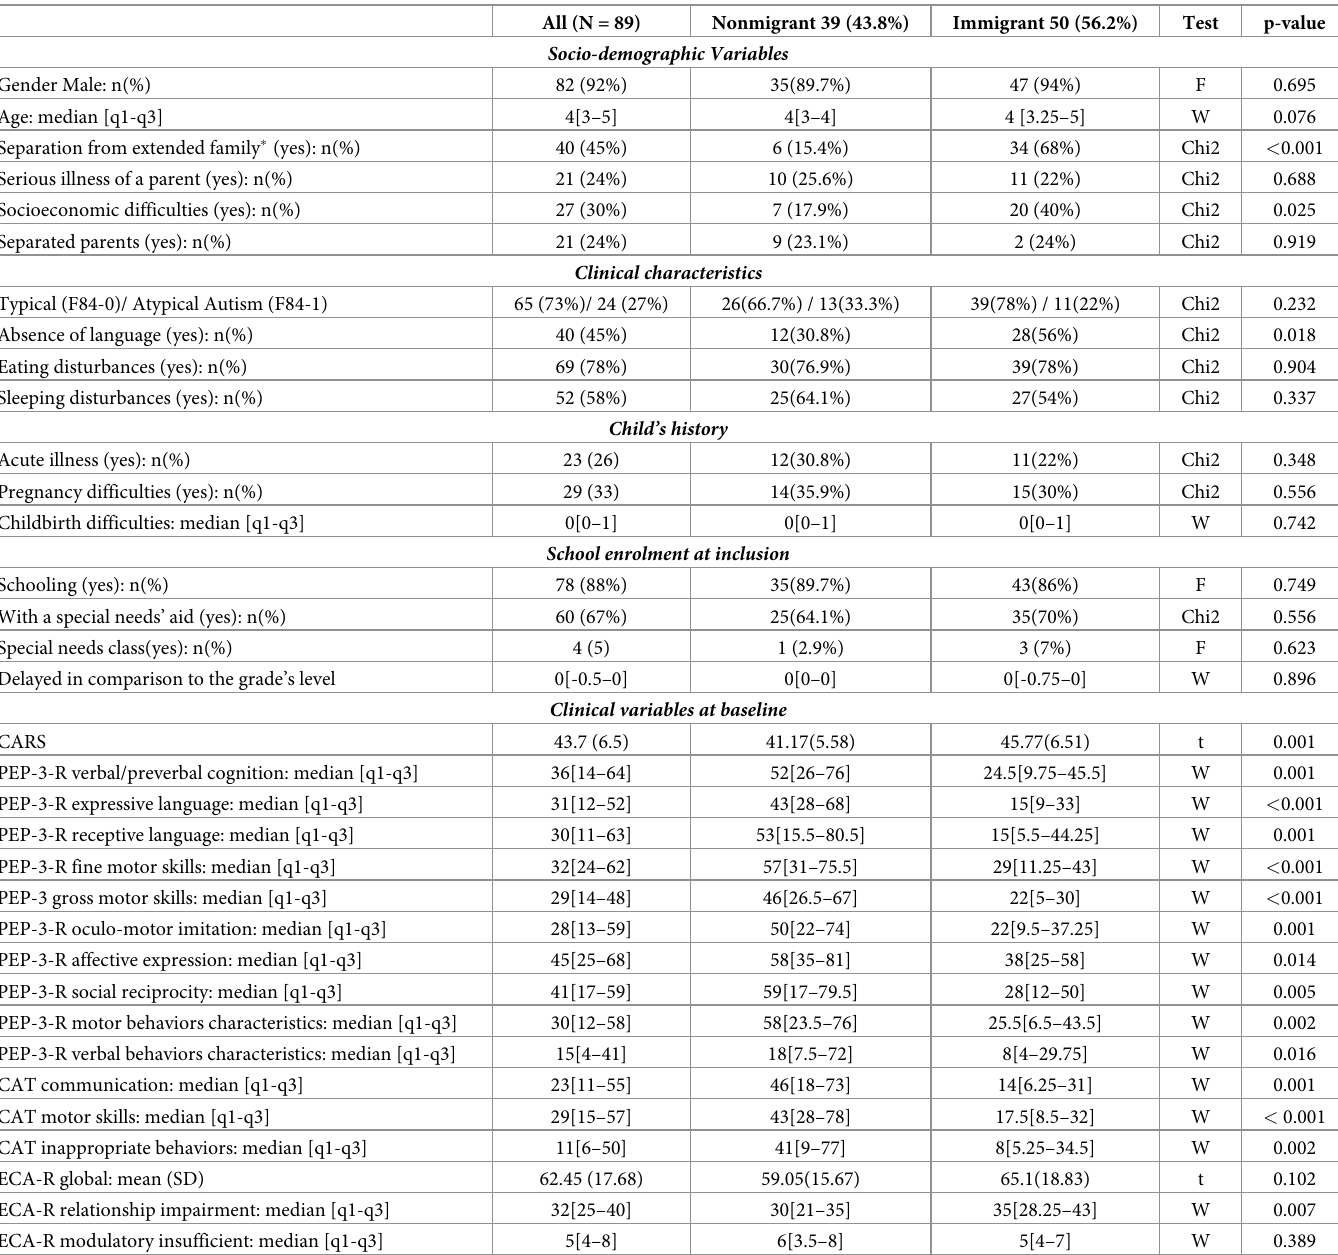
Table 2. Characteristics of the children included in the EPIGRAM study at baseline (N = 89). All (N = 89) Nonmigrant 39 (43.8%) Immigrant 50 (56.2%) Test p-value Socio-demographic